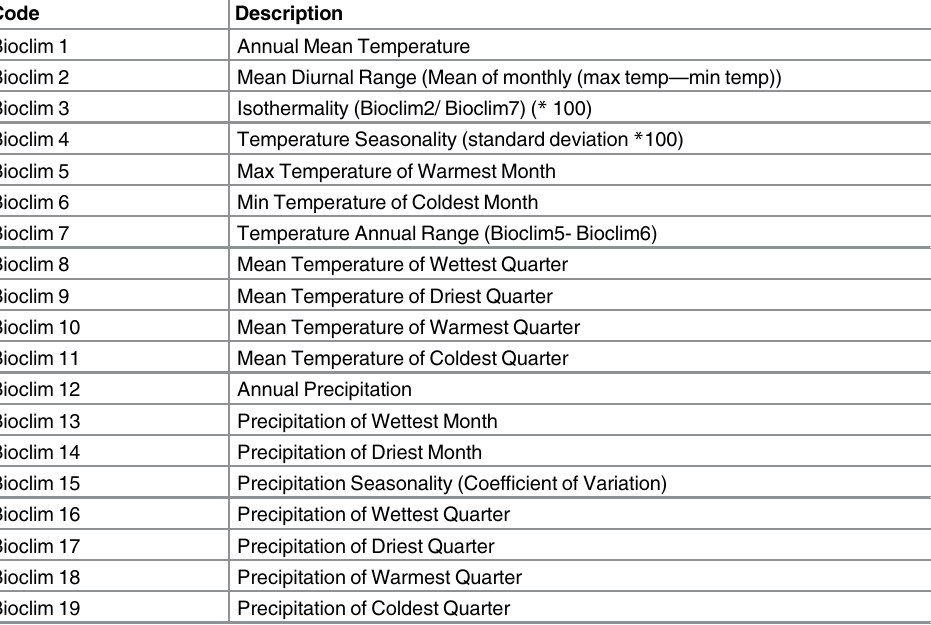
Table 2. Coding of bioclimatic variables according to WorldClim at